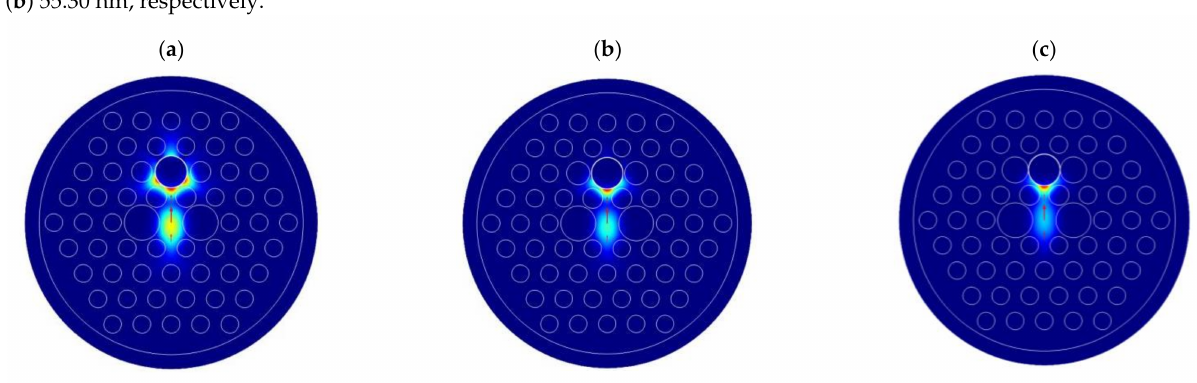
Figure 3. Distribution of the electric field of Y-polarized CM varied with d 3 = ( a ) 1.40, ( b ) 1.60, ( c ) 1.80 µ m and d 1 = 2.40 µ m,